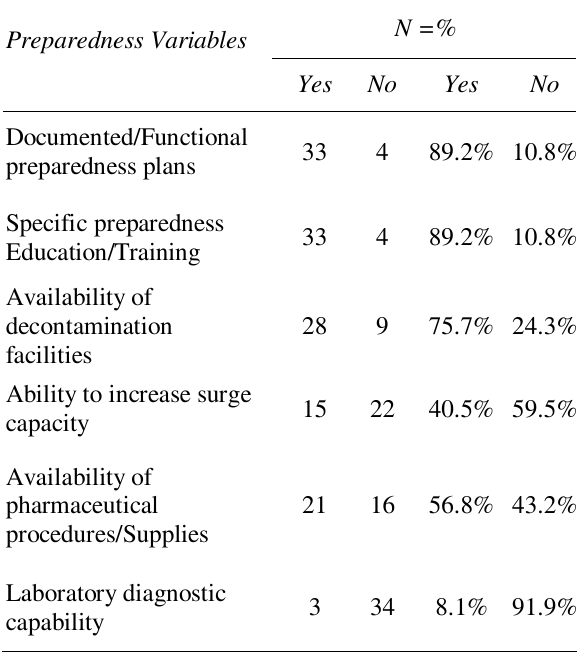
Table 2: Frequency distribution of preparedness